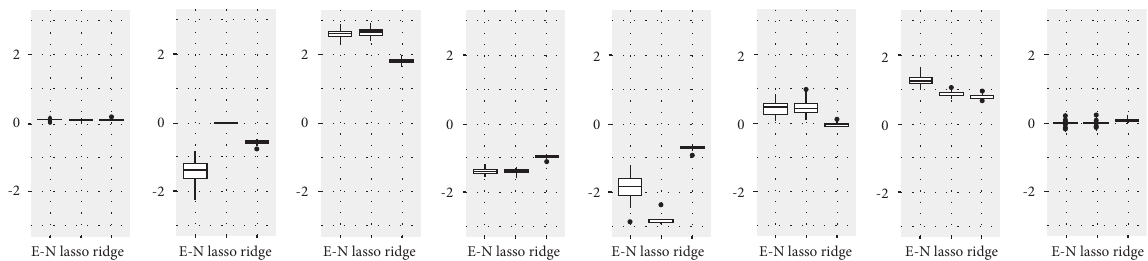
Figure 10: Box plot of regression coefficients under repeated